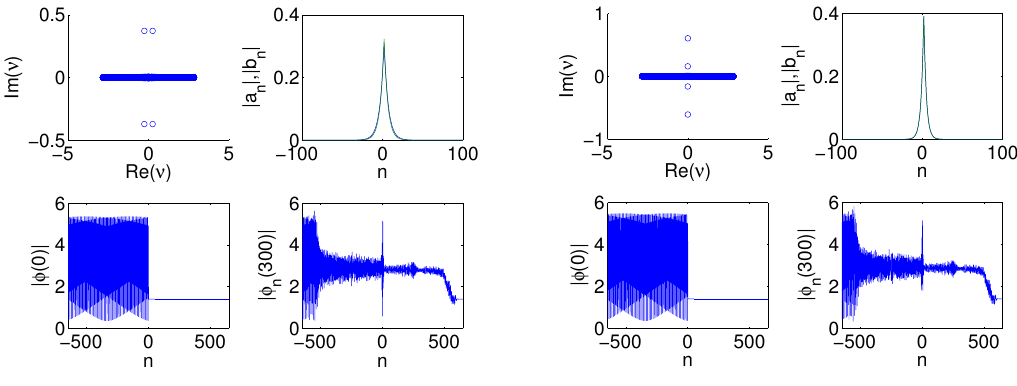
Figure 5. Here we focus on parameter values that correspond to the left panel of Figure 3. Again we show four plots similar to the right panel of Figure 2. Here we have N = 2 , L = 1300 and k = 2 . The left panel of four plots corresponds to γ T = 1 . 4 , and the right panel corresponds to γ these two sets of four plots shows the transition in the eigenvalue plots as we move towards brighter regions of the appropriate | min( Im ( ν ) | diagram in Figure